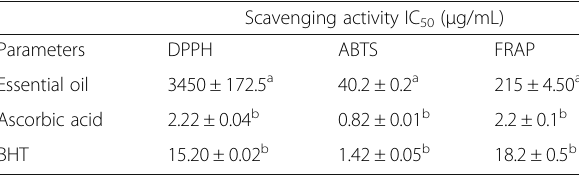
Table 2 Antioxidant activities of aerial parts of M.